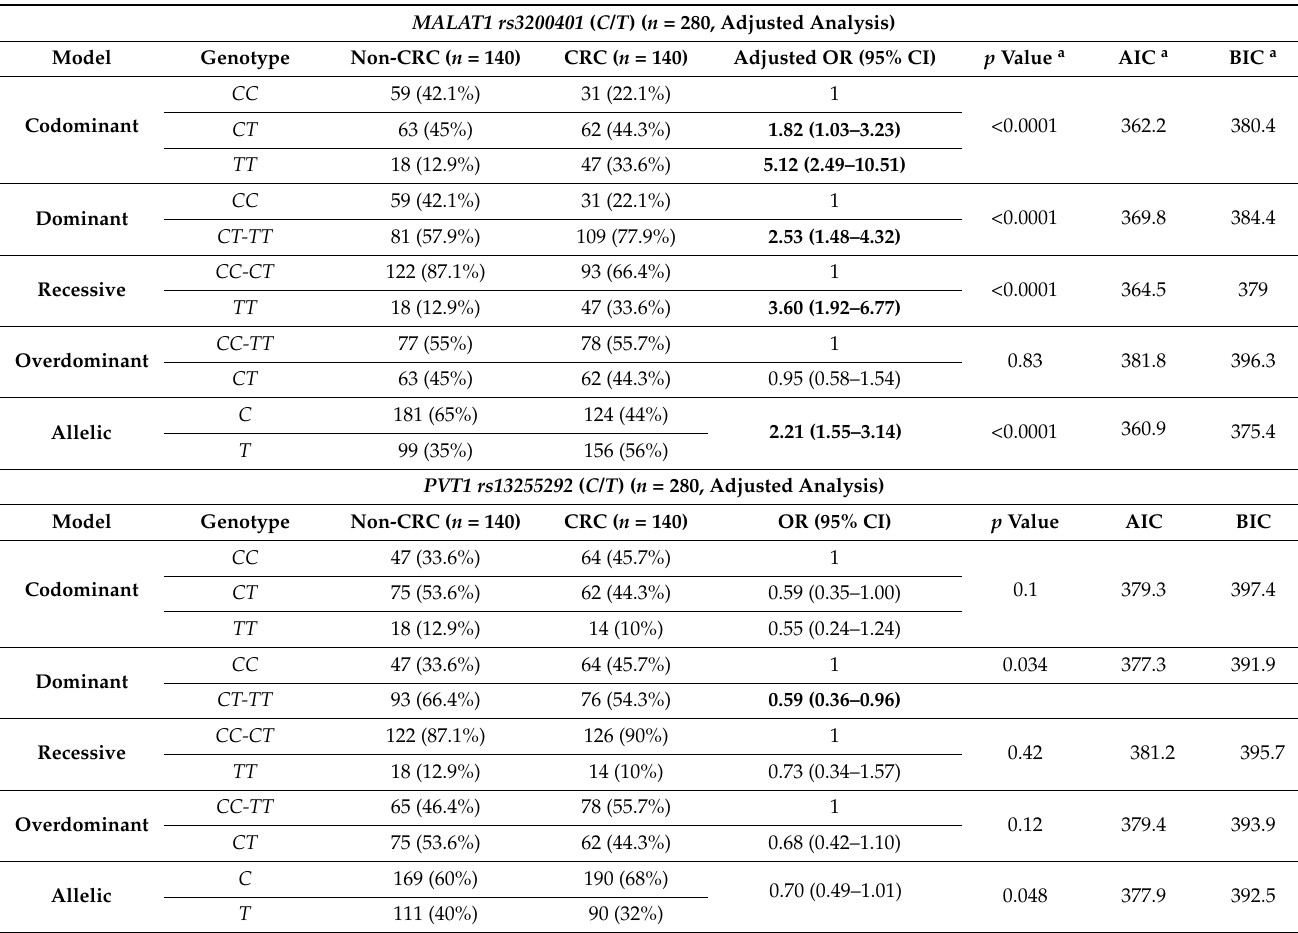
Table 3. Genotype and Allele Frequencies of MALAT1 rs3200401 ( C / T ) and PVT1 rs13255292 ( C / T ) in CRC and Non-CRC.